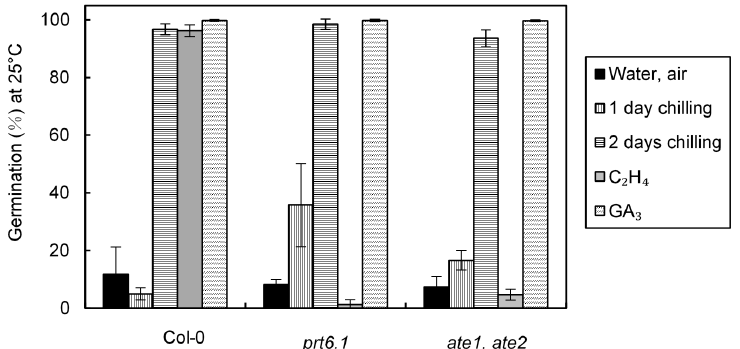
Figure 3. Germination percentages obtained after seven days at 25 °C with Col-0 and the N-end rule mutants ( prt6-1 and ate1-ate2) seeds placed directly at 25 °C on water without ethylene (control) or in the presence of ethylene 100 ppm, at 25 °C in the presence of GA 3 1 mM and at 25 °C after 1 and 2 days of incubation at 4 °C. Means of three replicates ± SD. Seeds harvested in 2016.